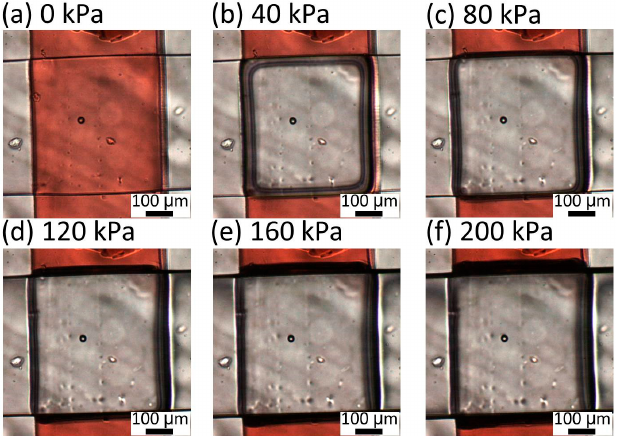
Figure 8. Center of intersection between the two microchannels of the microvalve with a 40- μ m-thick membrane under pressures of ( a ) 0; ( b ) 40; ( c ) 80; ( d ) 120; ( e ) 160; and ( f ) 200 kPa.